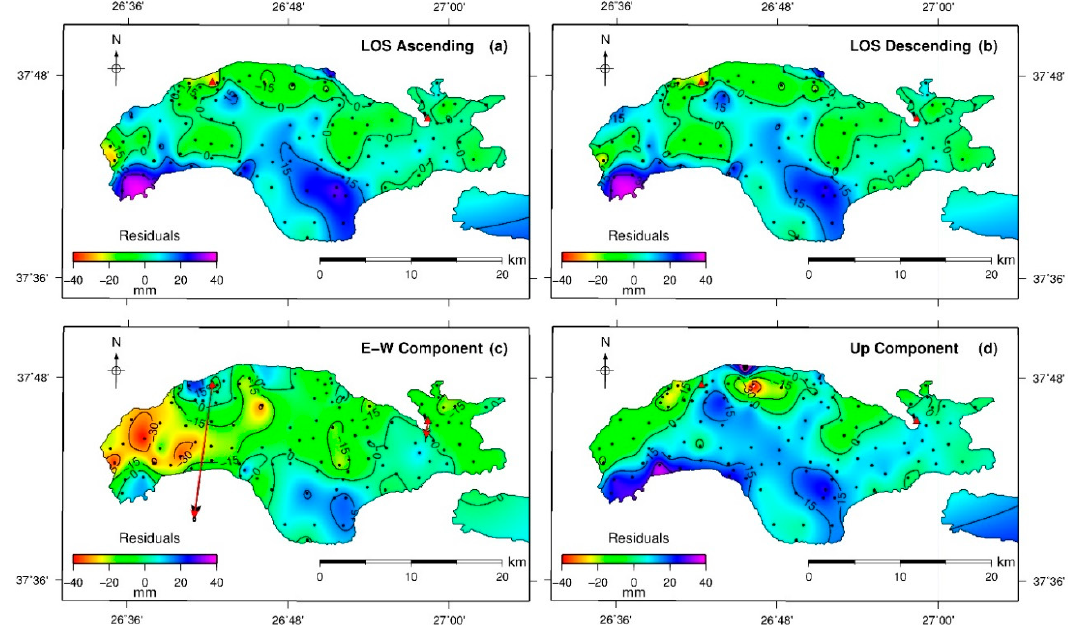
Figure 11. Residual maps showing the difference between observed and calculated data for the LOS modelled displacement vectors for ( a ) ascending and ( b ) descending orbits. ( c , d ) Residual maps of E–W and vertical components for the 110- modelled points/targets (black circles). The fit of the GNSS horizontal displacement vectors are included in ( c ) where black arrows are observed, and red arrows are modelled.